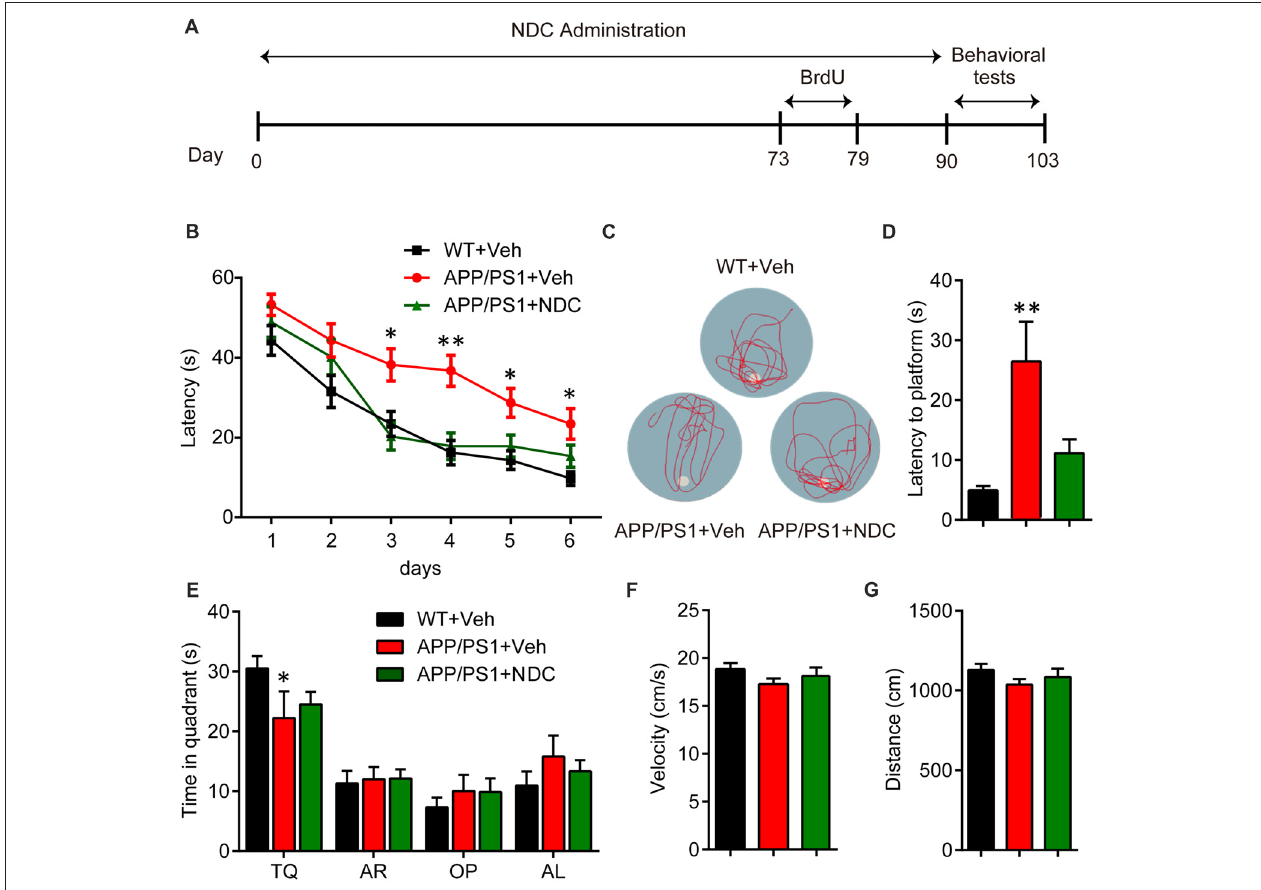
FIGURE 1 | Naringin dihydrochalcone (NDC) ameliorates learning and memory deficits in APP/PS1 mice. (A) Experimental procedure for Morris water maze (MWM) analysis. (B) MWM test of wild type (WT) mice and vehicle- or NDC-treated APP/PS1 mice. (C) Representative track images of each group mice in day 7 probe